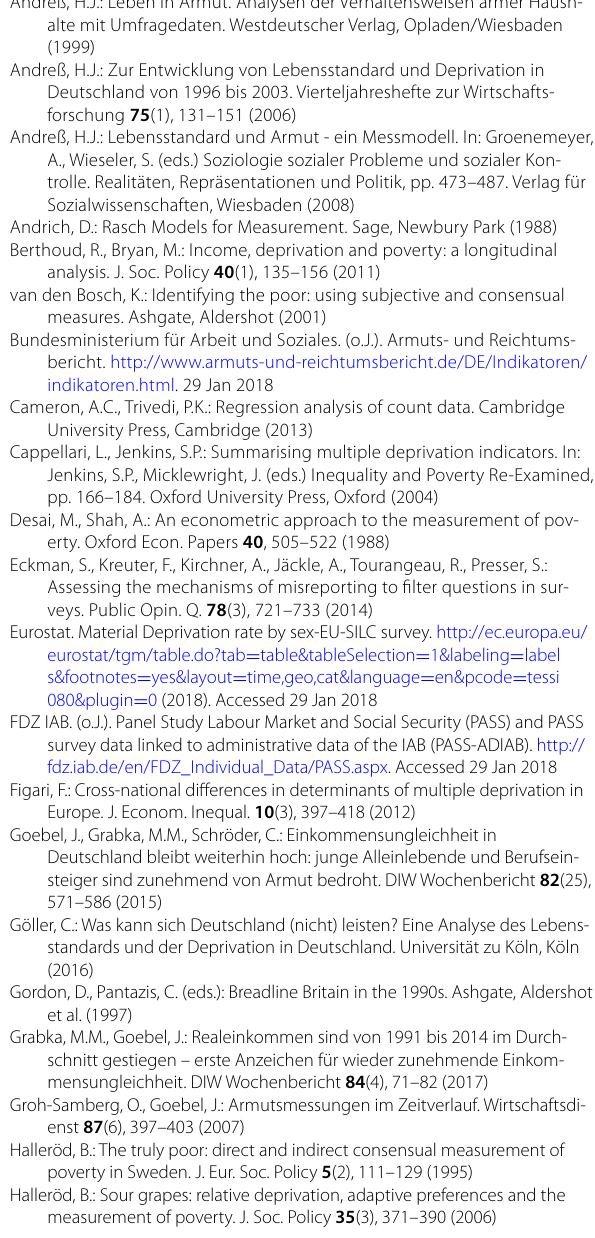
Figari, F.: Cross‑national differences in determinants of multiple deprivation in Europe. J. Econom. Inequal. 10 (3), 397–418